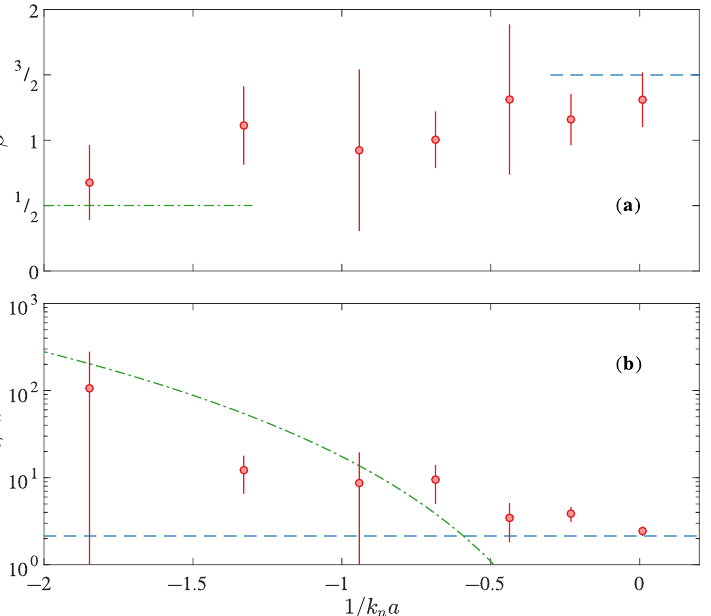
Figure 4. Characteristic exponent and time constant. By fitting a power law 1 − ( t / t c ) β to the coherence amplitude, we obtain the characteristic exponent ( a ) and time constant ( b ) at various interaction strengths. The theoretically predicted exponent and time constants for universal and weak coupling dynamics are shown as a dashed blue line and a dash-dotted green line, respectively. The errors correspond to fit